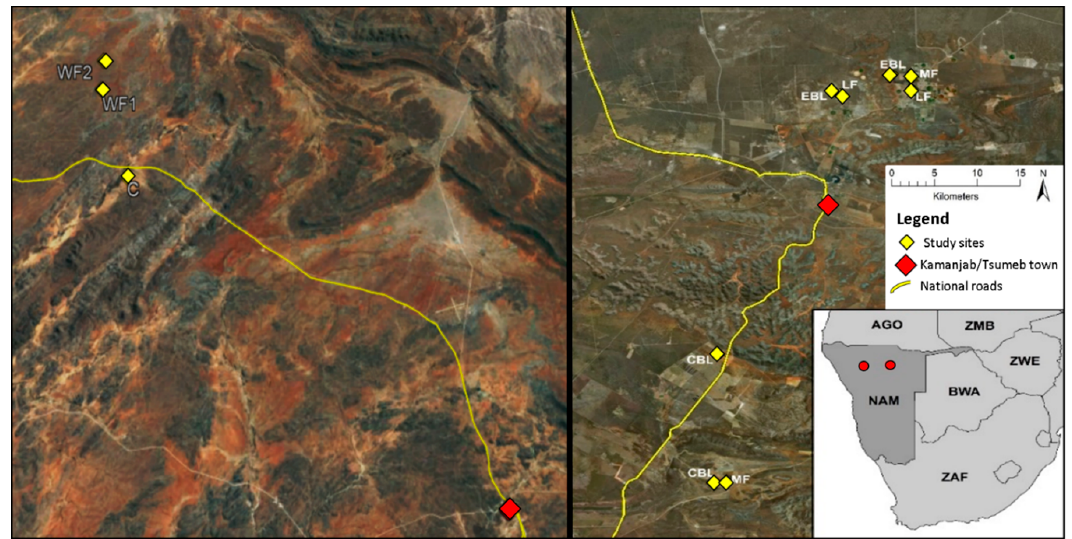
Figure 2. Location of the study areas (red circles in overview map) and sampling sites (yellow diamonds) in Namibia: (1) left—at the southern boundary of ENP near the city of Kamanjab and (2) right—around the city of Tsumeb; WF1/ WF2 = wildlife rangeland, wildlife rangeland in 1000 m/50 m distance to waterhole; C = livestock rangeland grazed by cattle; EBL/ CBL = encroached bushland/cleared bushland, MF/ LF = maize/lucerne field.